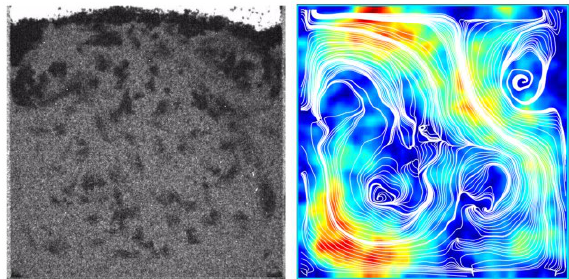
Fig. 6. Example image of recent application aimed at improving imaging- as well as simulation-approaches: moving inclusions in electromagnetically agitated liquid metal, comparison image obtained with neutrons versus fluid dynamic numerical simulation